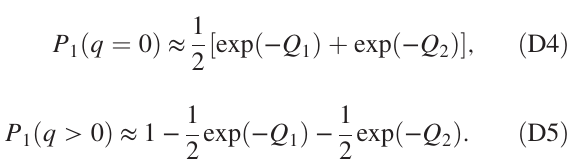
Figure 12 plots the Fisher information for misaligned binary SPADE, showing a similar degradation behavior to that in Fig. 11 for nonzero ξ . Significant improvements over direct imaging are still possible for small separations and ξ ≪ 1 .